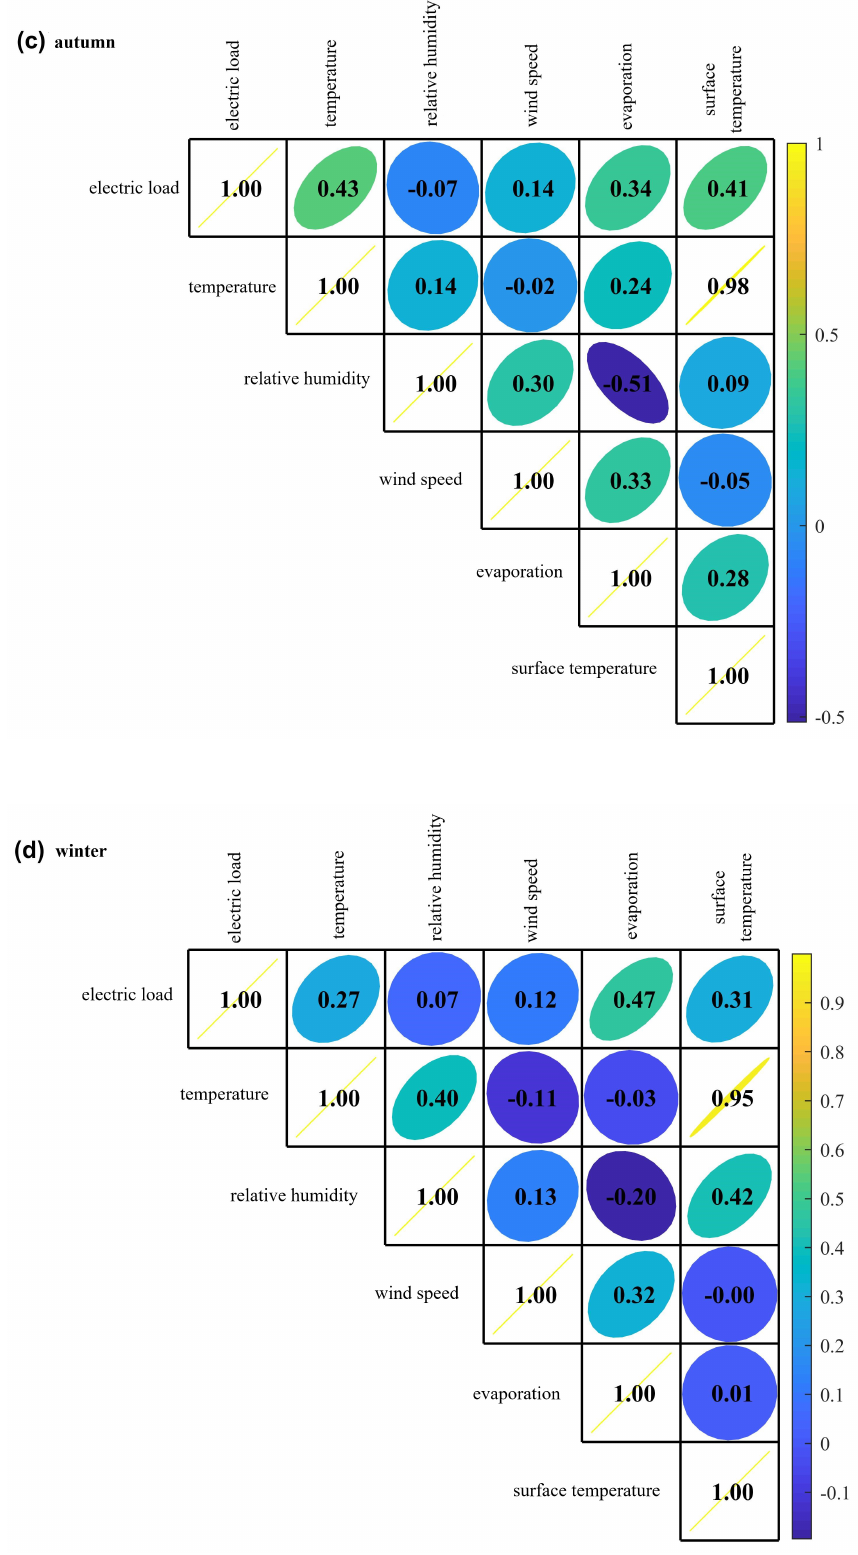
Figure 5. Correlation analysis of daily load and meteorological factors in different seasons. ( a ) Spring (March 1 to June 3); ( b ) Summer (June 4 to September 3); ( c ) Autumn (September 4 to December 3); ( d ) Winter (December 4 to February 28 of the following year)